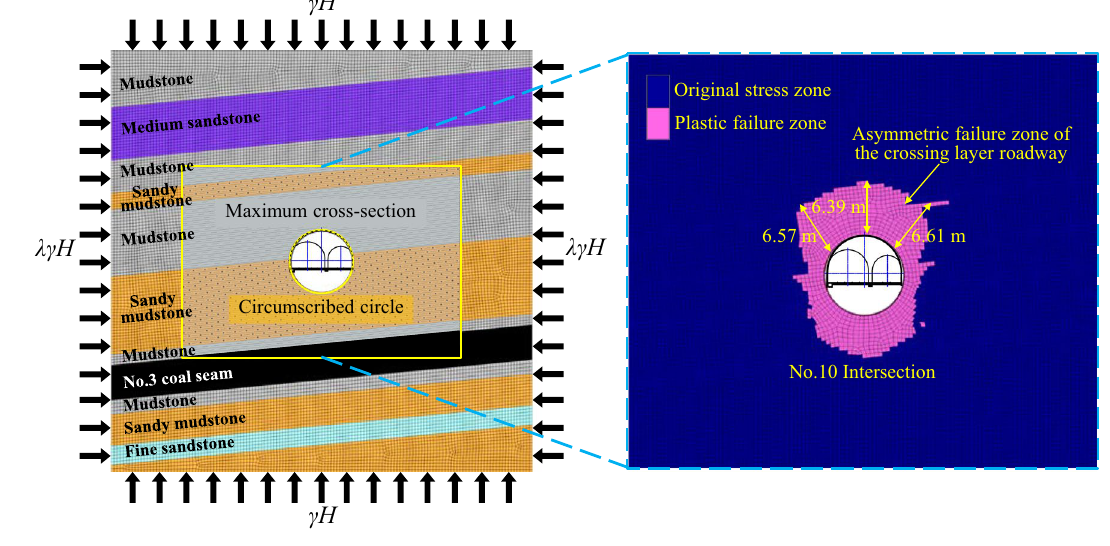
Fig. 15 Cloud map of the plastic zone at the No. 10 intersection